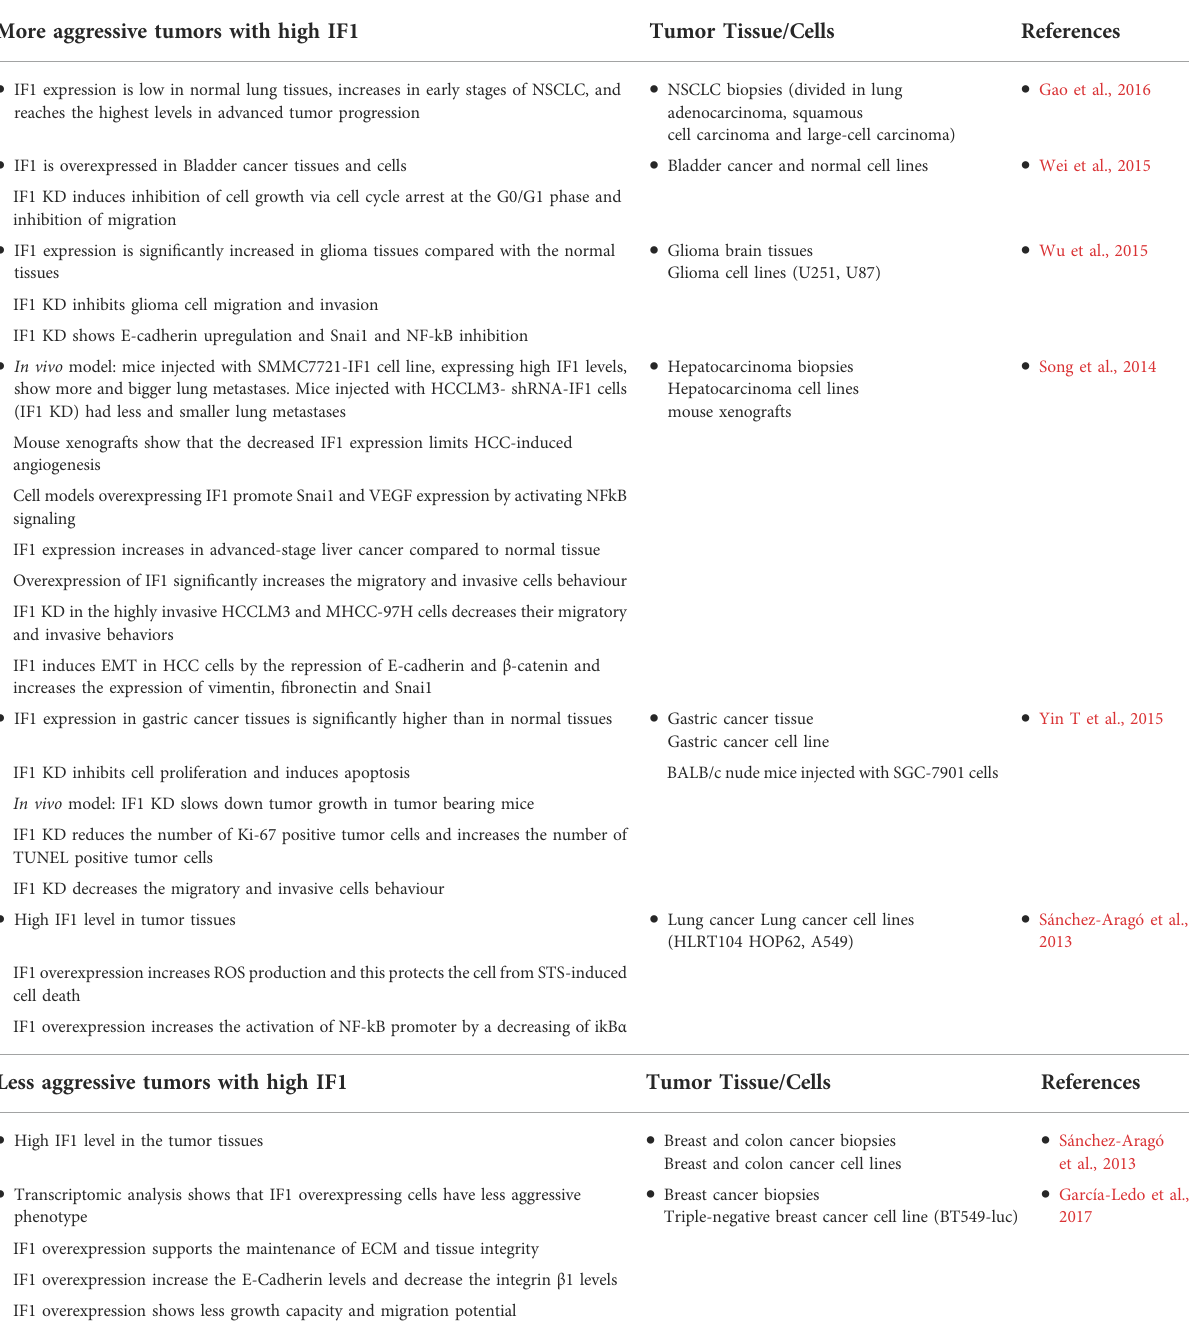
TABLE 1 The effects of IF1 expression levels on tumor growth, migration and metastasis in different models. More aggressive tumors with high